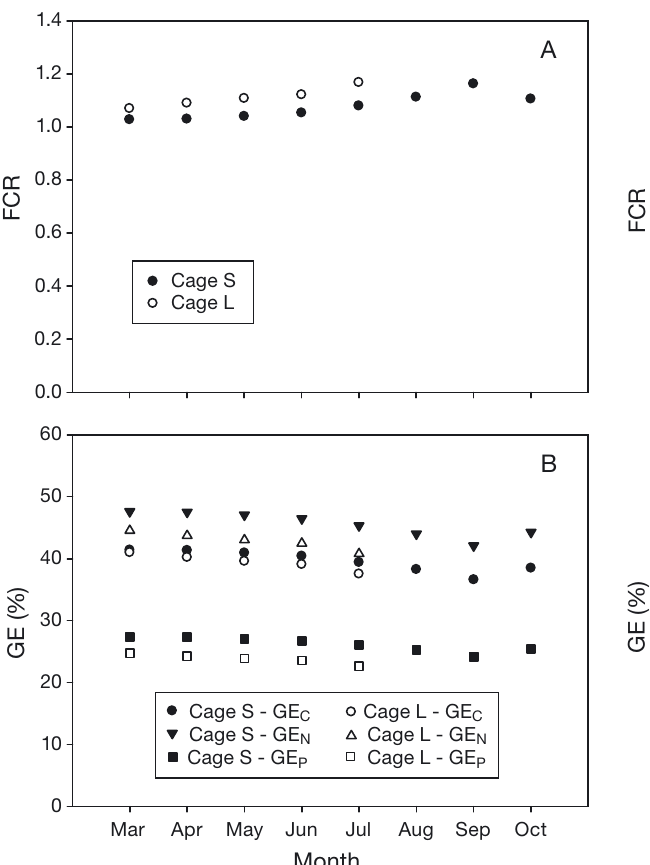
P:C ratios were in the range of 12 to 20 µg P mg −1 C (mean = 17 ± 2.7 µg P mg −1 C) and the N:P ratios were